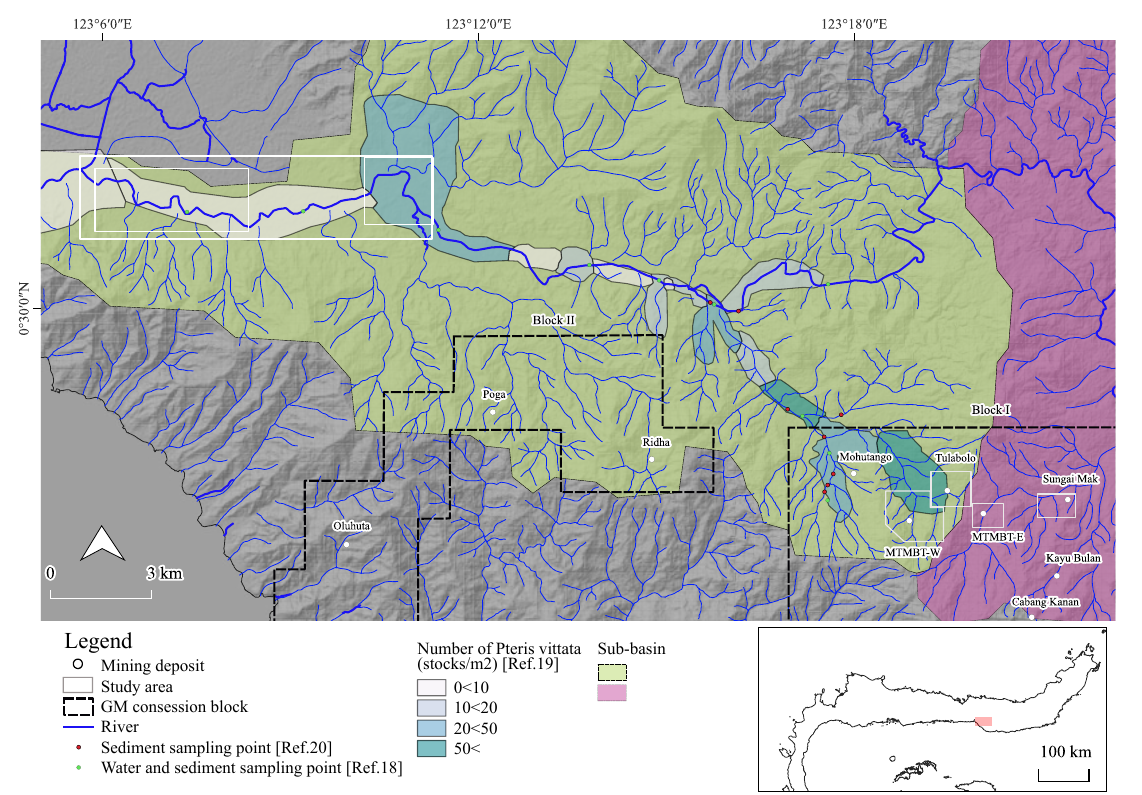
Figure 4. Georeferenced map of water and sediments sampling points and plants (Pteris vittata) distribution in the study